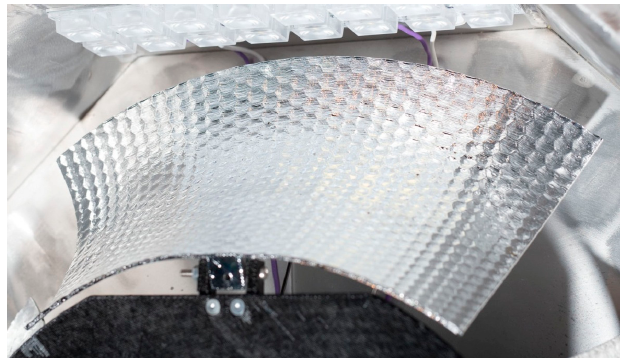
Figure 18. View of the finished reflector with a diffusing macrostructure and a metallic layer sputtered on it.